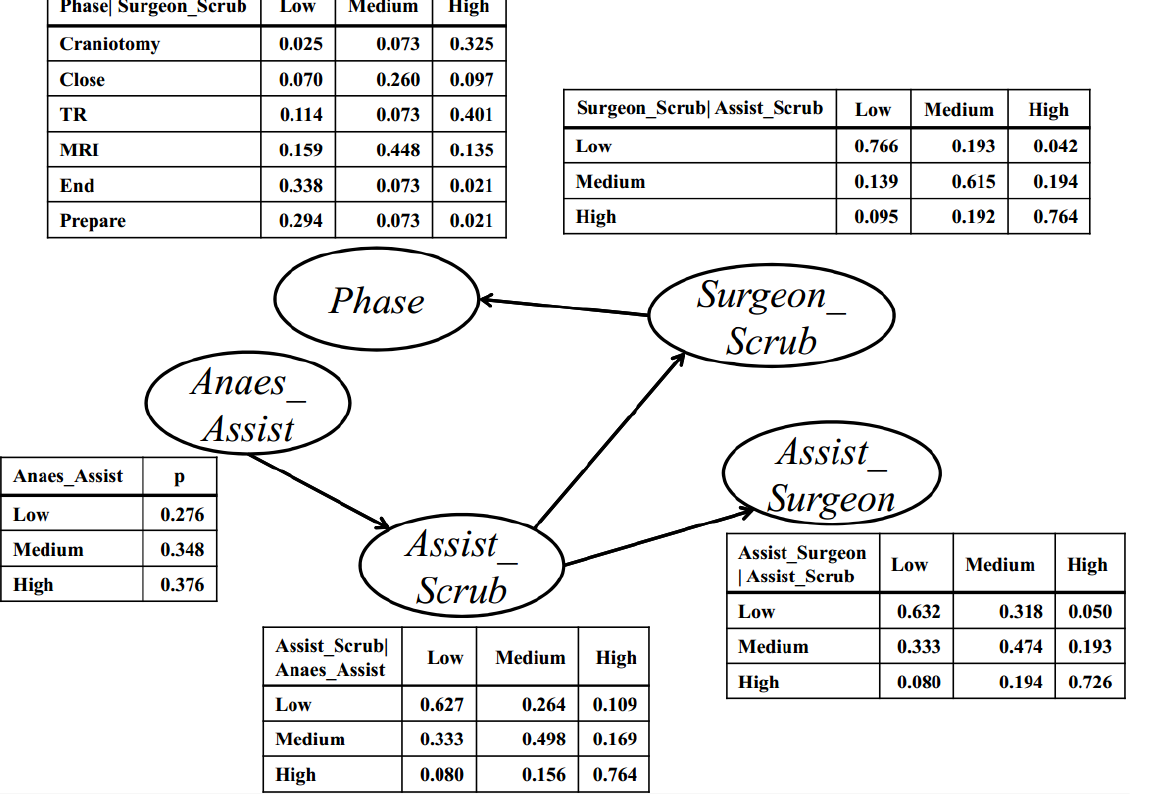
Figure 6. The learned BN structure and conditional probability table.